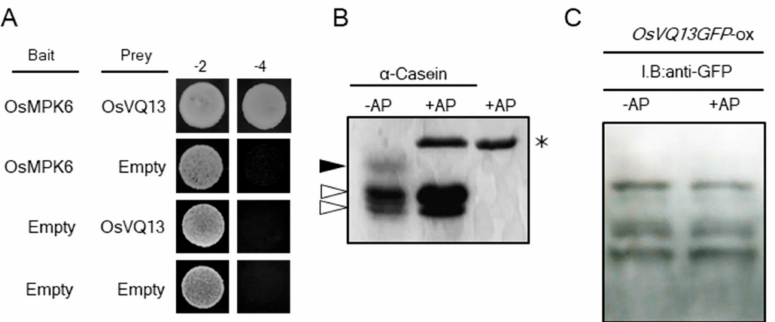
Figure 4. Phosphorylation assay of OsVQ13. ( A ) Interaction between OsVQ13 and OsMPK6 using yeast cells. The yeast AH109 strain was dropped on synthetic dropout (SD) glucose medium lacking Leu and Trp ( − 2) or on SD glucose medium lacking Ade, His, Leu, and Trp ( − 4). ( B ) Phosphorylation assay of the α -casein protein through Phos-tag ® PAGE. Here, α -casein was a control protein treated with alkaline phosphatase ( + AP) or untreated (-AP) (as indicated), separated through Phos-tag ® SDS-PAGE. The black arrowhead indicates phosphorylated- α -casein, and the white arrowheads indicate dephosphorylated α -caseins. An asterisk indicates an AP protein. ( C ) Phosphorylation assay of the OsVQ13 protein through Phos-tag ® PAGE. Purified OsVQ13GFP proteins were treated with AP ( + AP) or were untreated ( − AP). The treated proteins were separated through Phos-tag ® SDS-PAGE and were detected using anti-GFP